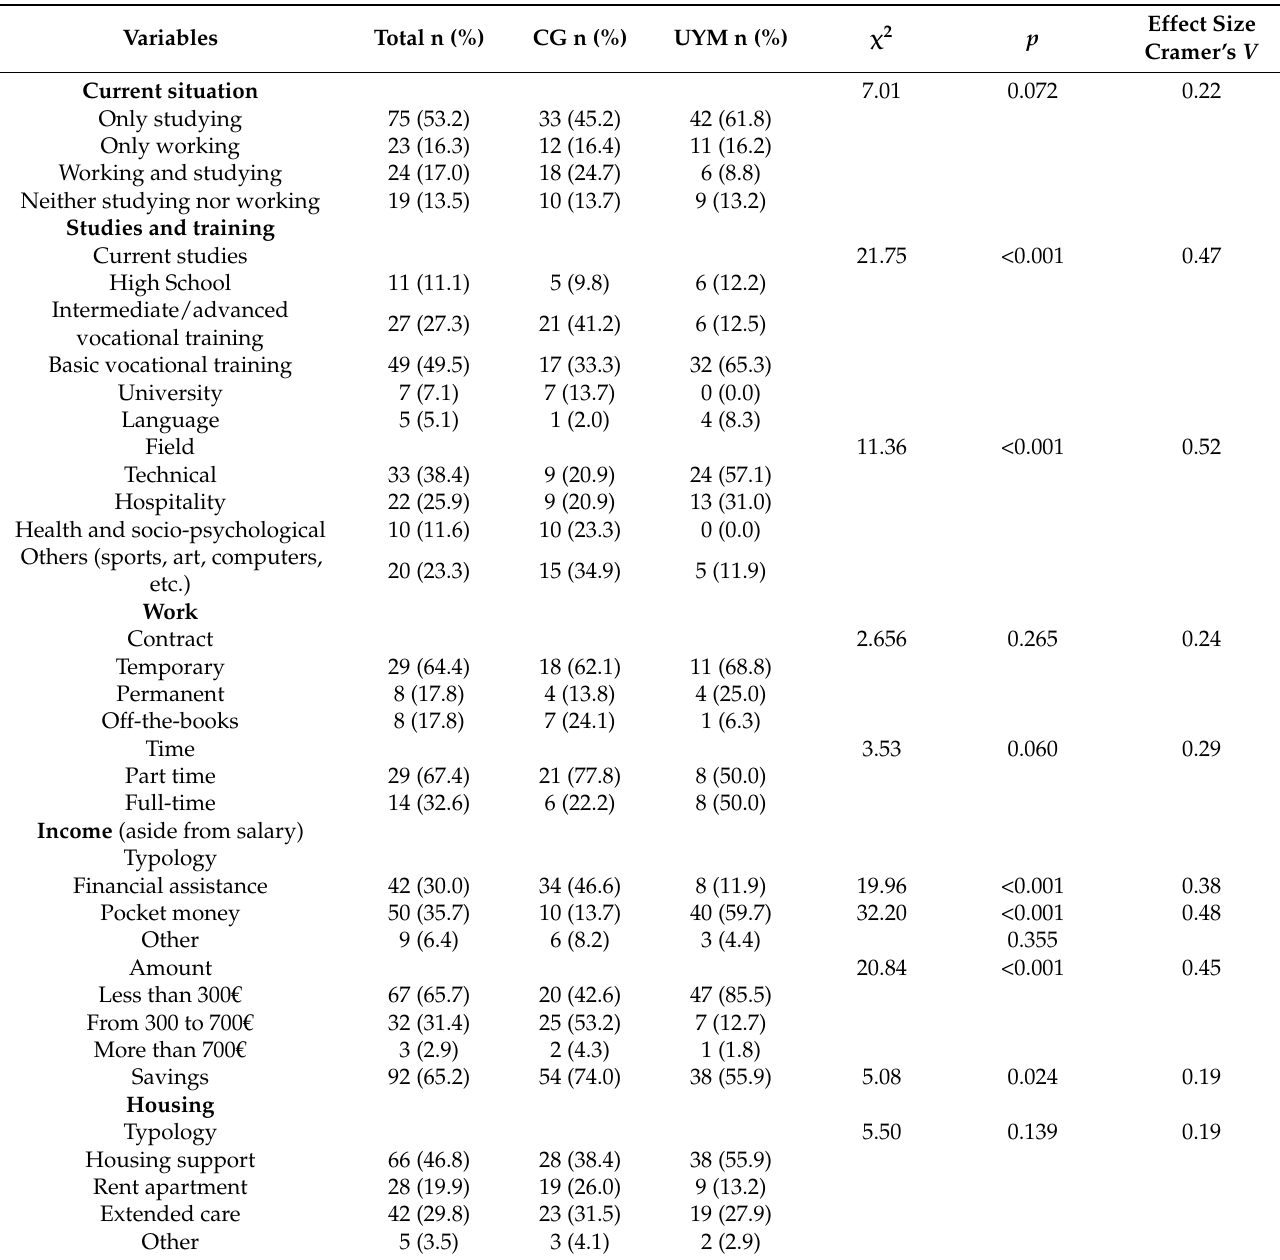
Table 3. Situation of Care Leavers. Differences between